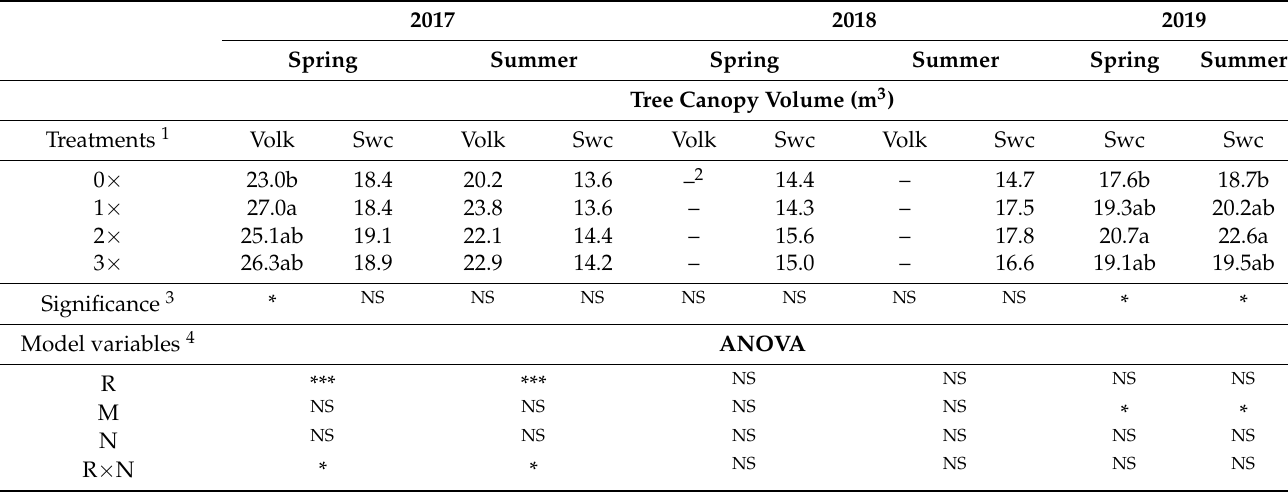
Table 5. Effect of rootstock and ground-applied plant nutrition on the tree canopy volume and ANOVA of Huanglongbing (HLB)-affected citrus trees cv. “Valencia” budded on Volkameriana (Volk) or Swingle (Swc) rootstocks at Immokalee, FL during the 2017–2019 growing